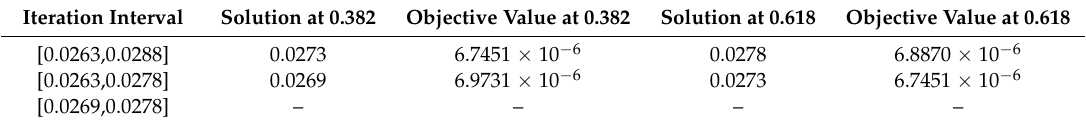
Figure 5. The convergence of SA.